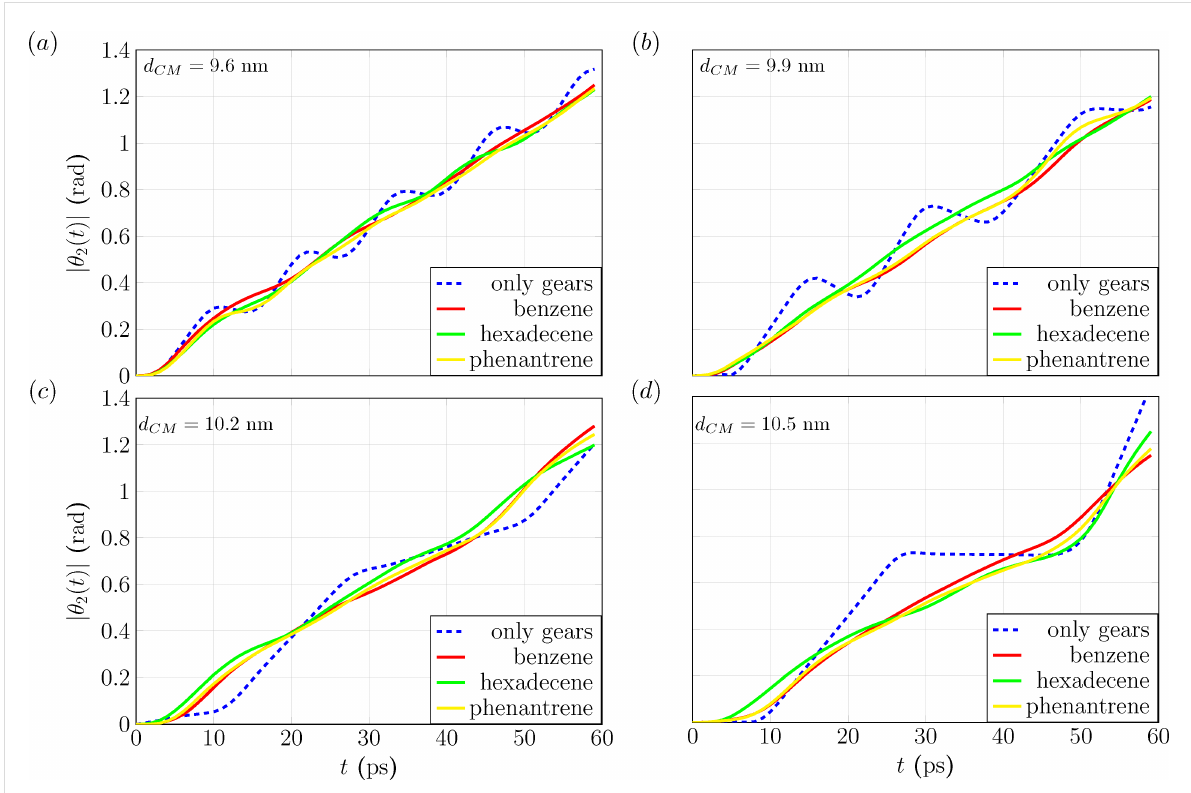
Figure 2: Trajectories of the rotation angle of the second gear θ 2 ( t ) without lubricant (blue dashed lines) and with lubricants, that is, benzene (red), hexadecene (green) and phenanthrene (yellow) from MD simulations within 60 ps for different center-of-mass distances d CM = (a) 9.6 nm, (b) 9.9 nm, (c) 10.2 nm and (d) 10.5